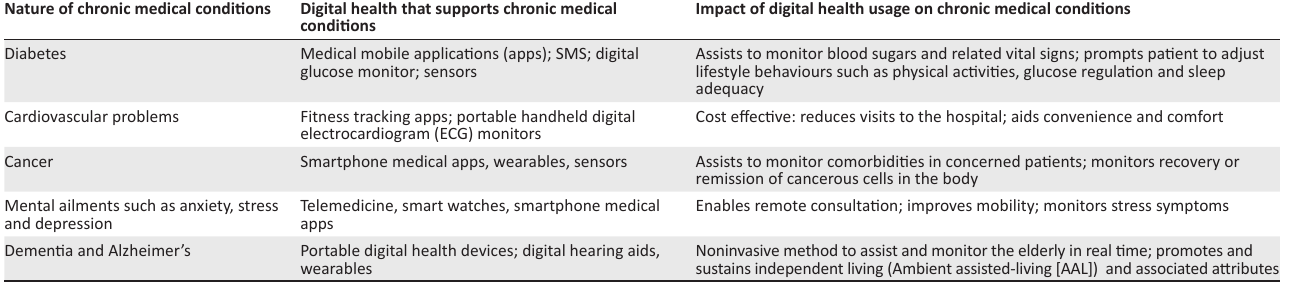
TABLE 1: Common chronic medical conditions and associated digital health technologies in sub-Saharan Africa. Nature of chronic medical conditions